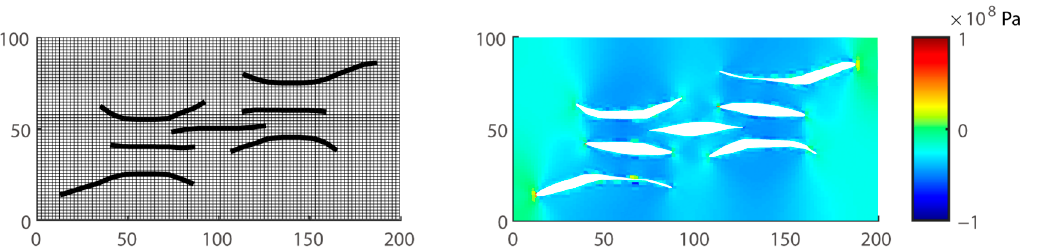
′ y , and fracture width distribution af‑